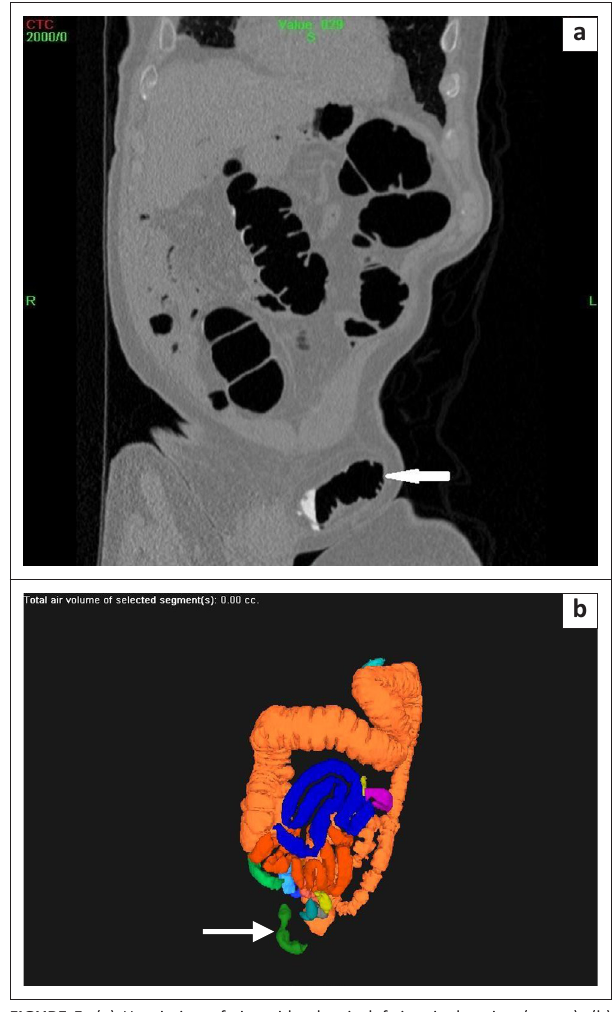
FIGURE 5: (a) Herniation of sigmoid colon in left inguinal region (arrow). (b) Small bowel in right inguinal region